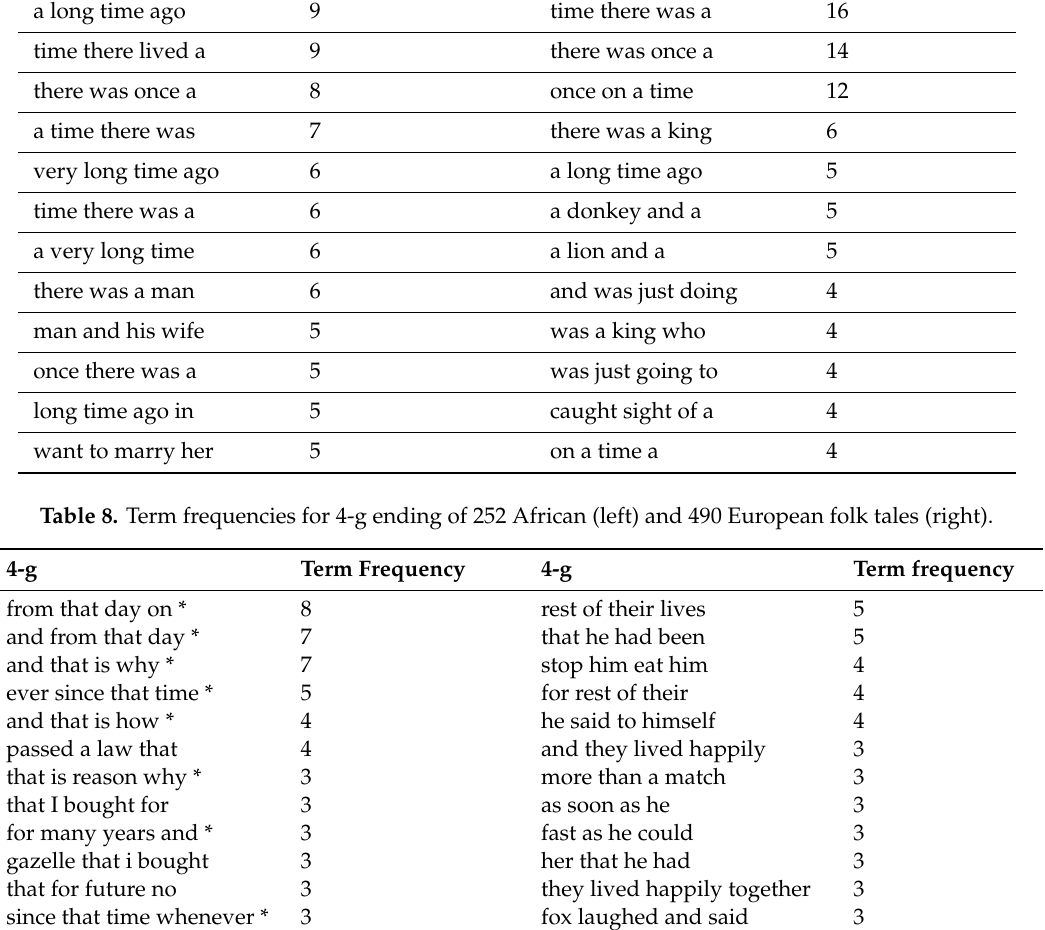
Table 7. TF-IDF 4-g beginning of 252 African (left) and 490 European folk tales (right). 4-g Term Frequency 4-g Term Frequency